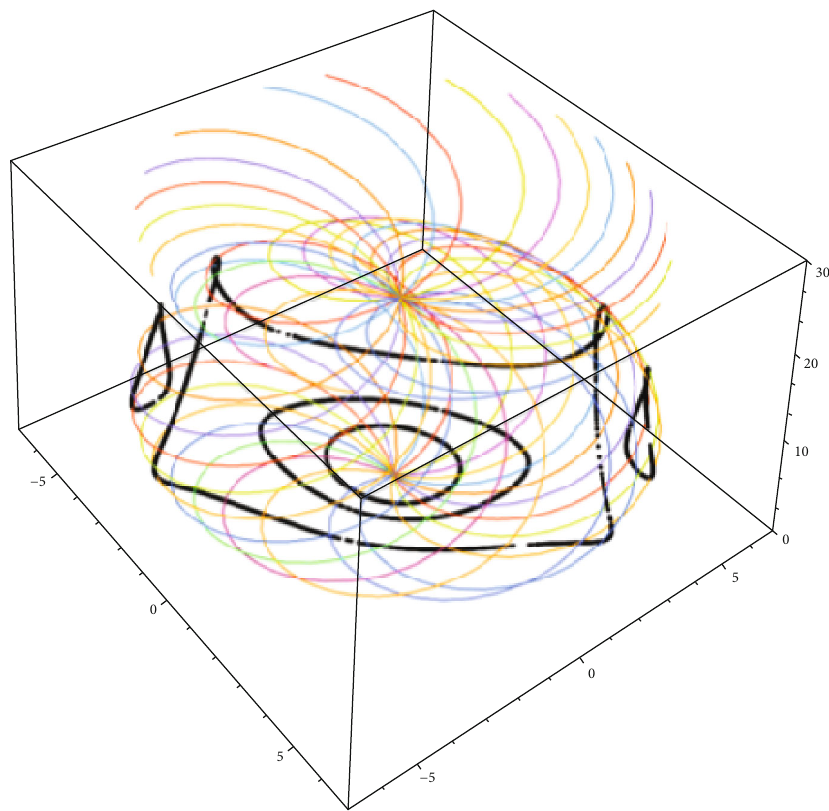
Figure 9: Three time cuts on the light cone at t = 1 : 5 , t = 2 : 4 , and t = 4 : 2 . The time cut at t = 1 : 5 is the closest closed loop near the origin. The cut at t = 2 : 4 is in three parts due to the nature of the time coordinate along the light rays.